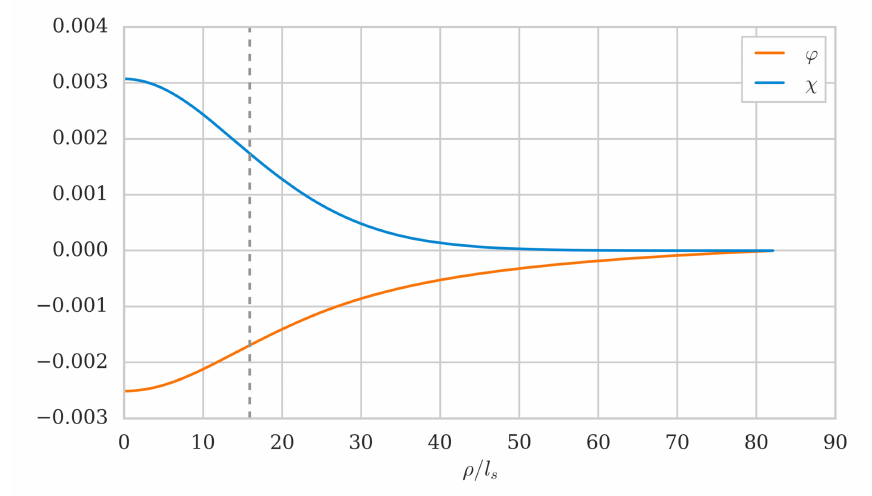
Figure 3 . An example of typical ϕ ( ρ ) , χ ( ρ ) profiles as a function of ρ (in string units). The numerical calculation was done for the d = 3 heterotic string with l Hagedorn temperature R d = 3 spatial dimensions and l